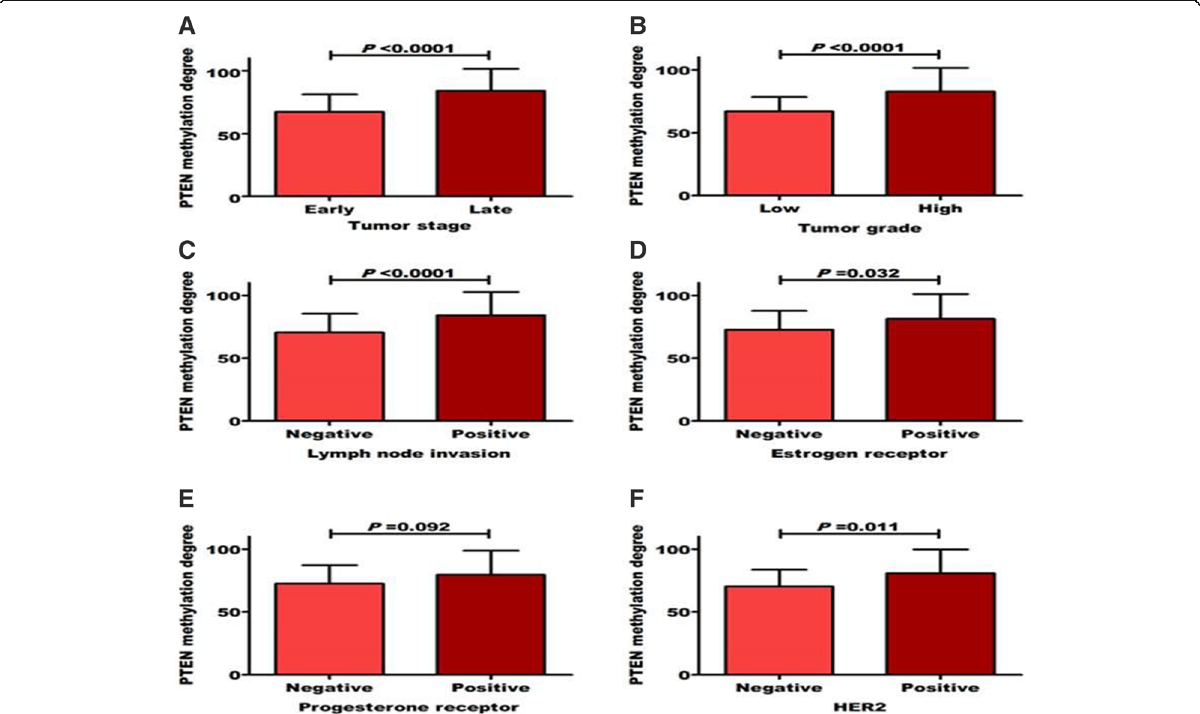
Fig. 3 Distribution of PTEN methylation degree among breast cancer patients according to tumor ( a ) stages, ( b ) grades, ( c ) lymph node, ( d ) estrogen receptor, ( e ) progesterone receptor, and ( f ) HER2 statuses. Significant difference was determined using Student ’ s t test. P value < 0.05 was considered